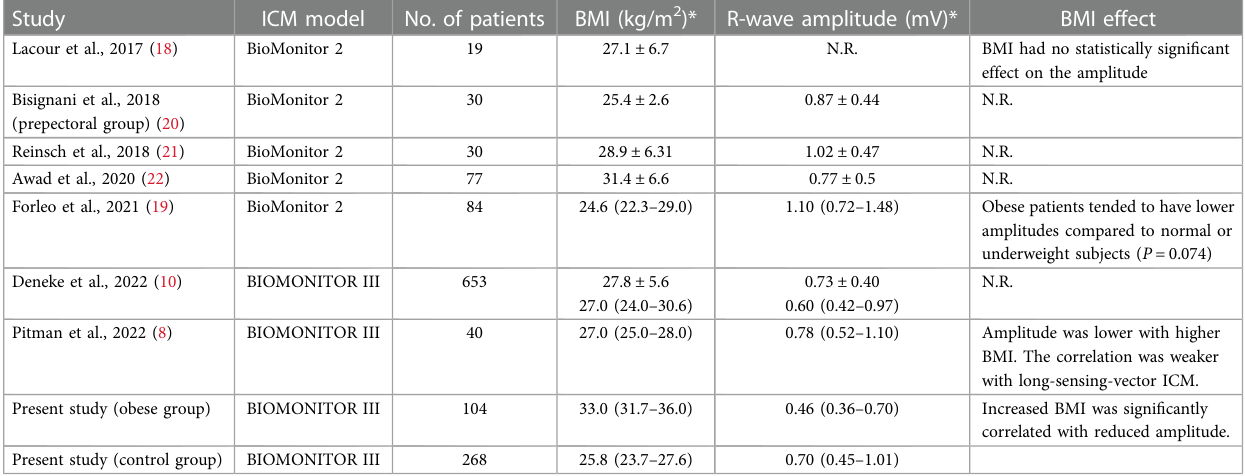
TABLE 5 Studies on long-sensing-vector ICMs reporting BMI and R-wave amplitude